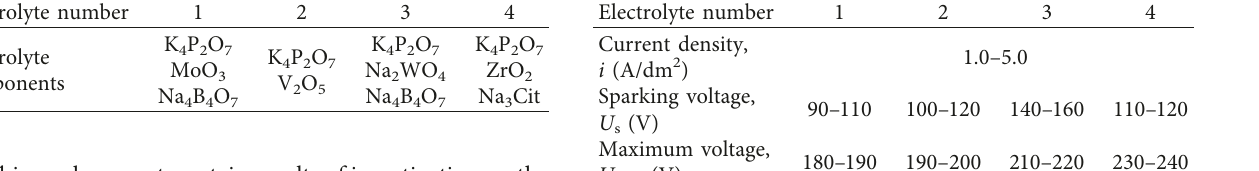
Table 1: Electrolytes for PEO. Electrolyte number